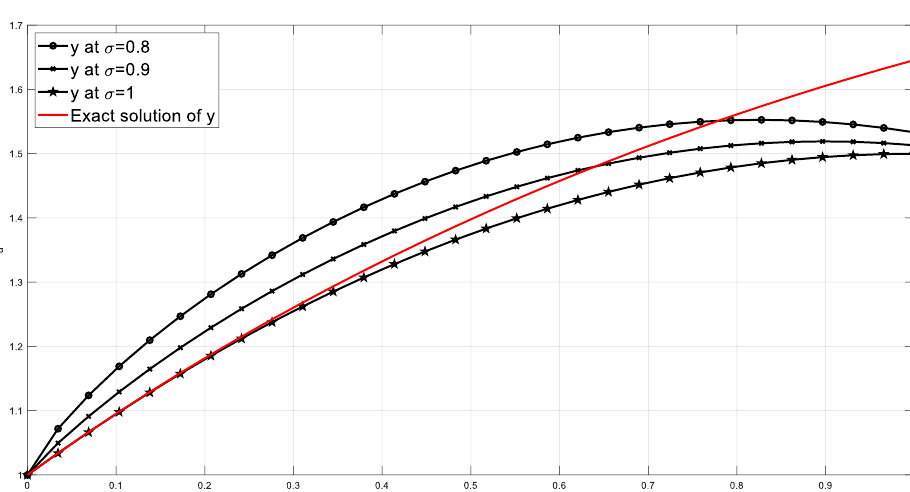
Figure 3. Approximate and exact solutions of Equation (26). Figure 4. Approximate and exact solutions of Equation